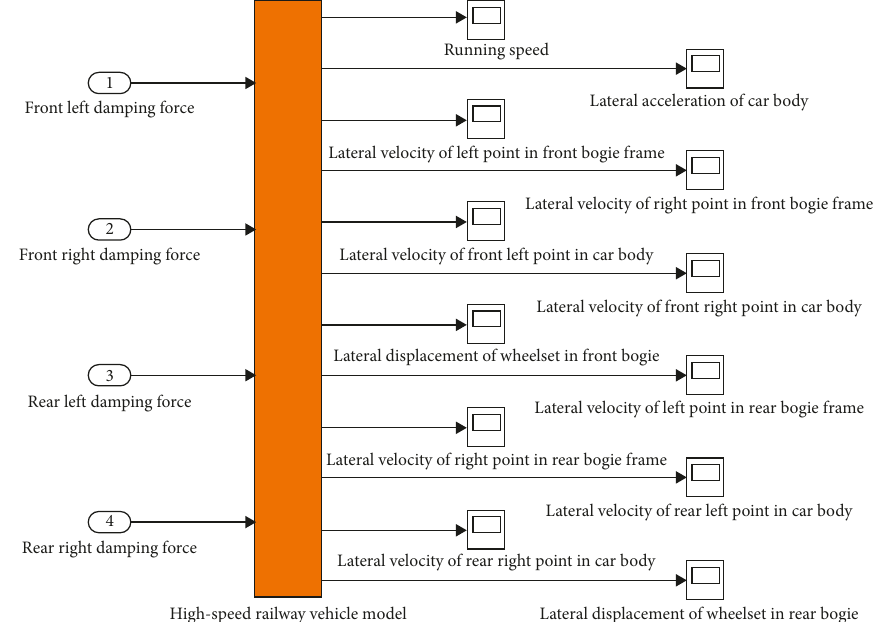
Figure 20: Cosimulation railway vehicle model.